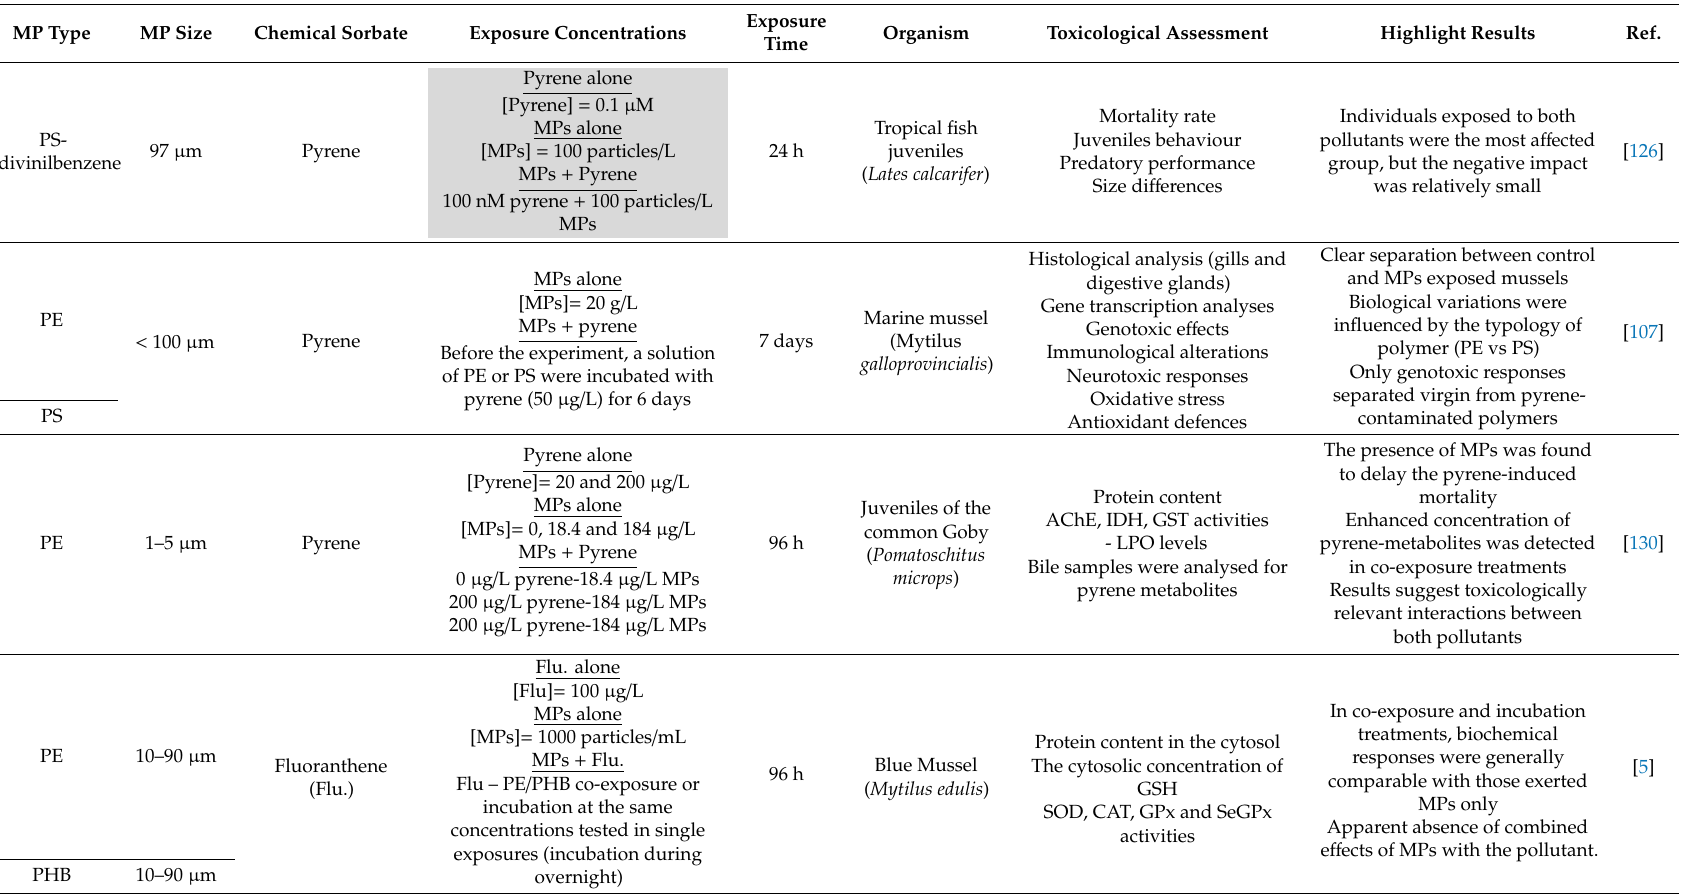
Table 2. Studies assessing the possible synergetic / antagonistic e ff ect of persistent organic compounds (POPs) combined with